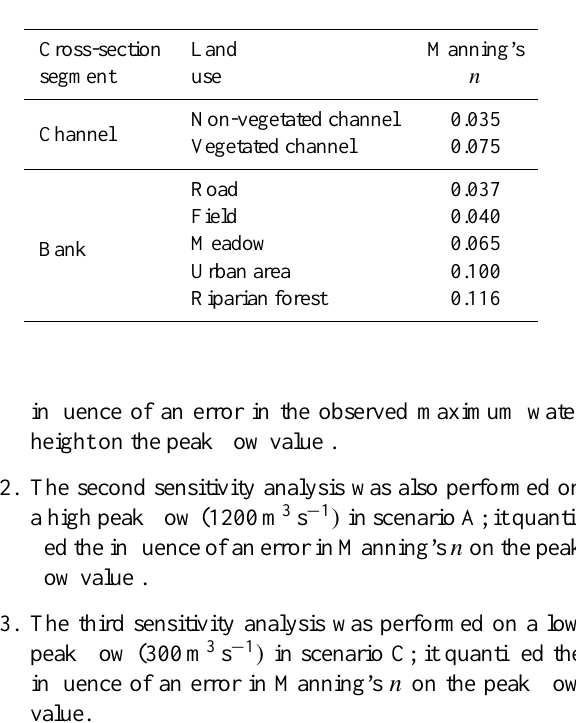
Table 2. Land uses identified at Sant Agust´ı Street cross-section (number 1147) in scenario C and their related Manning’s n